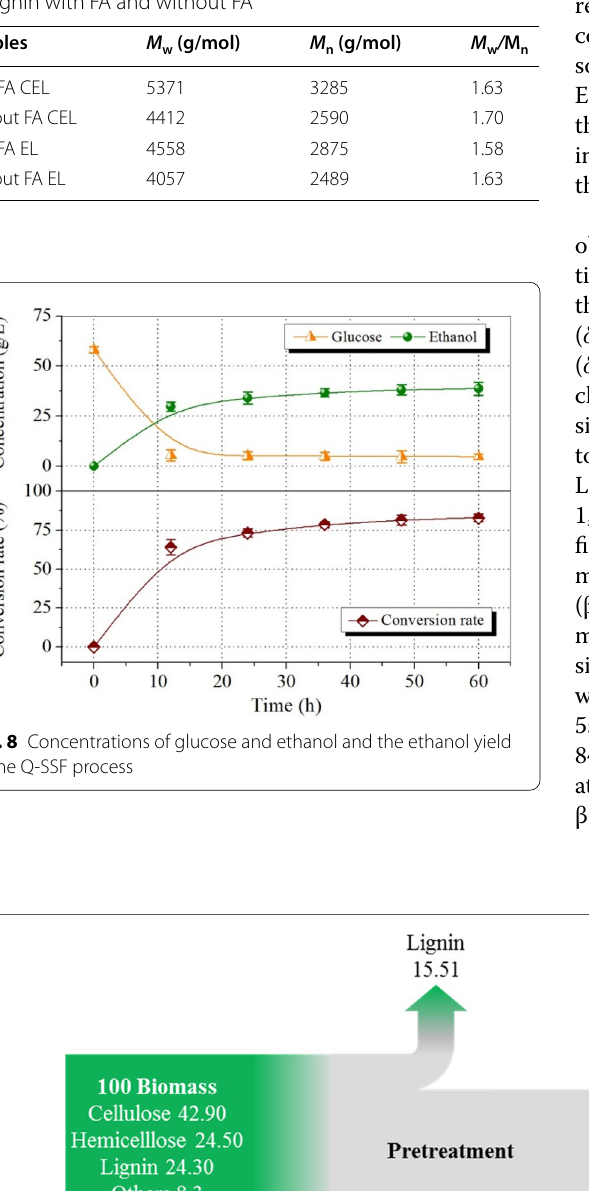
Table 1 Weight-average molecular weight, number-average